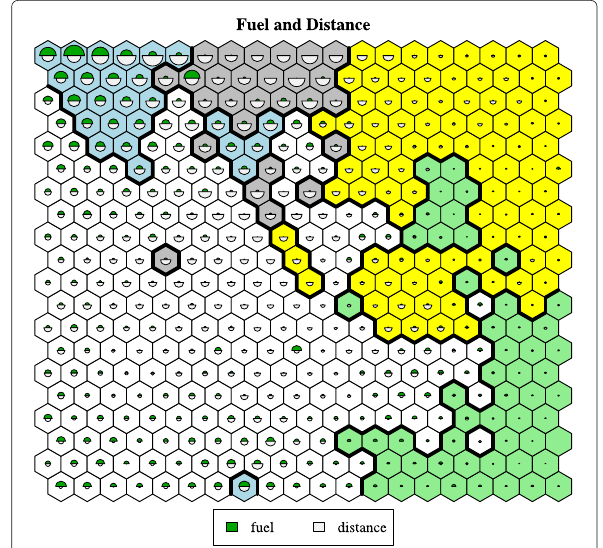
Fig. 9 Fuel and Distance map. Total distance and fuel consumption of each node cumulated for 10 seconds are represented as a sector plot within the respective node, where the size of the sector represents the